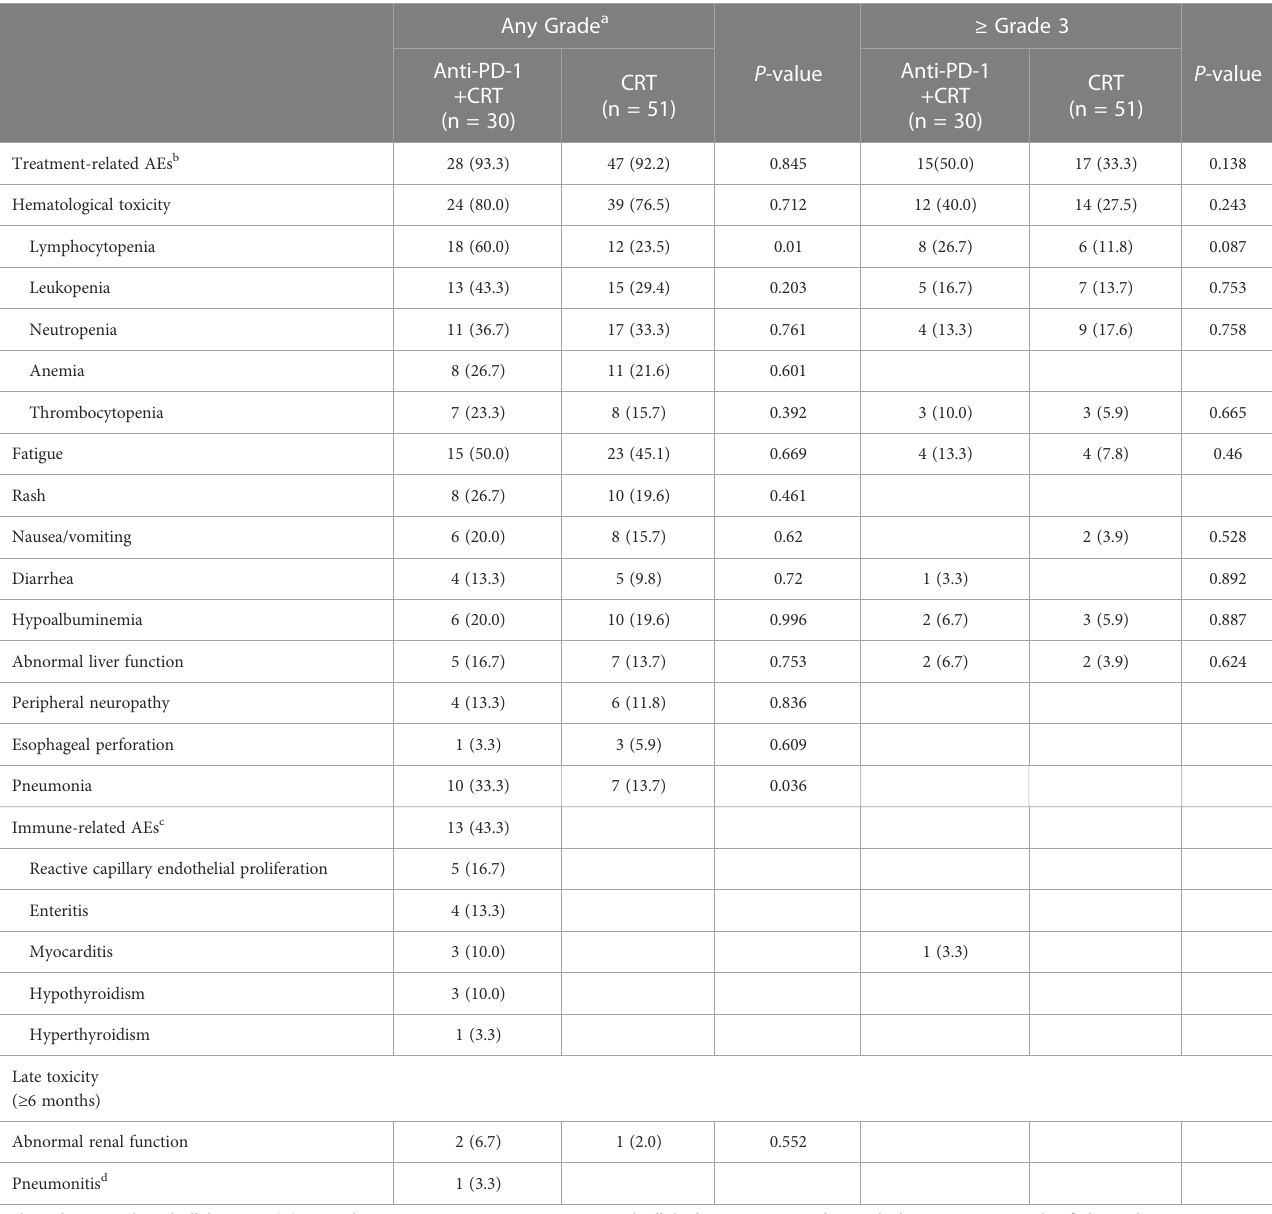
TABLE 3 Incidence of Treatment-related toxicities.